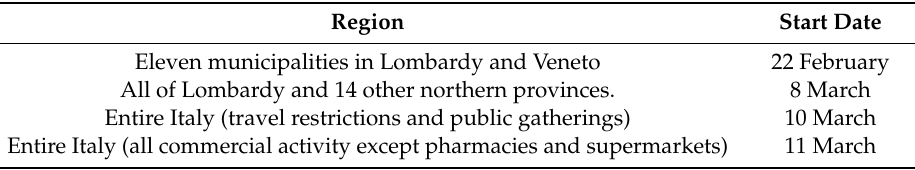
Table 2. The lockdown program in Italy to the spread of Coronavirus,